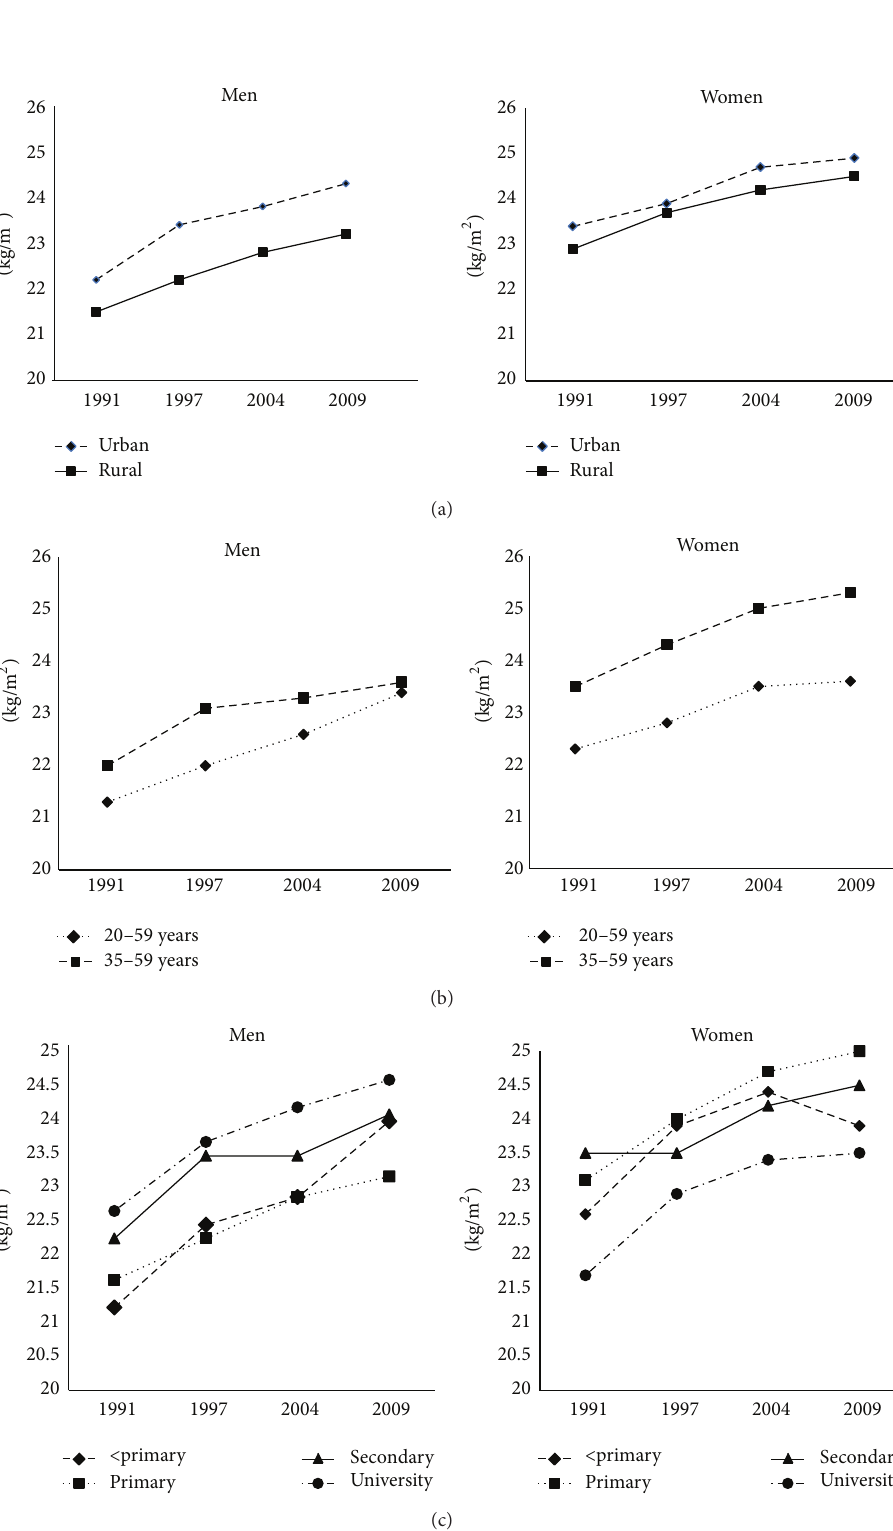
Figure 2: Age-adjusted mean BMI by sex, area of residence (a), age group (b), and education levels (c) in Thai adults aged ≥ 20–59 years, Thai NHES